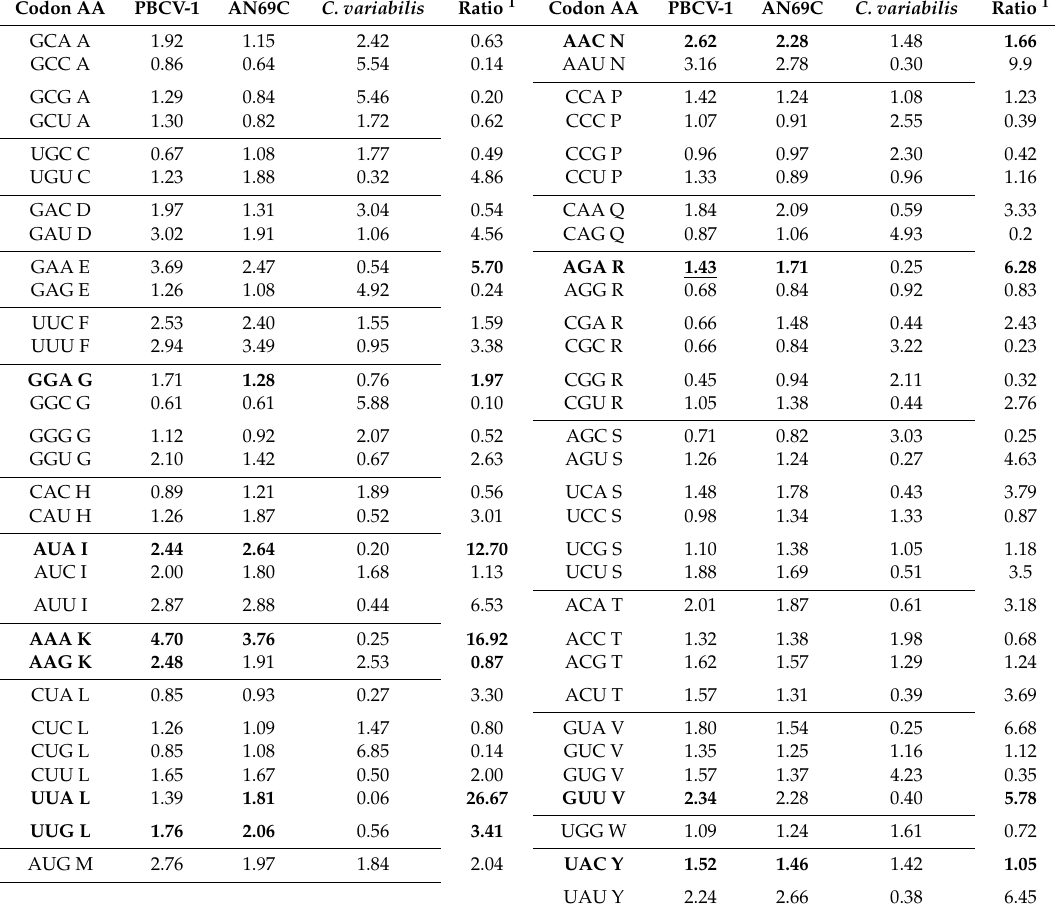
Table 5. Codon frequency use comparison of two chloroviruses, PBCV-1 and AN69C, to Chlorella host. Codon